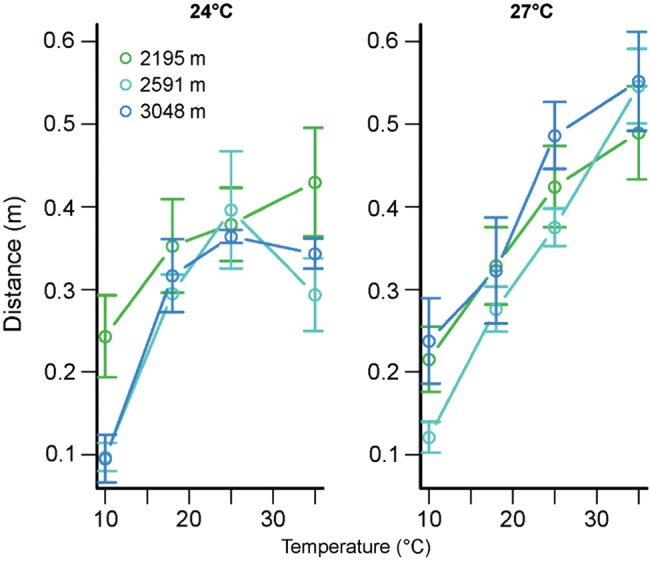
Hopping distance (in metres) as a function of temperature (in degrees Celsius) for M. sanguinipes reared in the laboratory at 24 (left panel) and 27°C (right panel). Mean values ± SEM are depicted, with colours distinguishing sites.